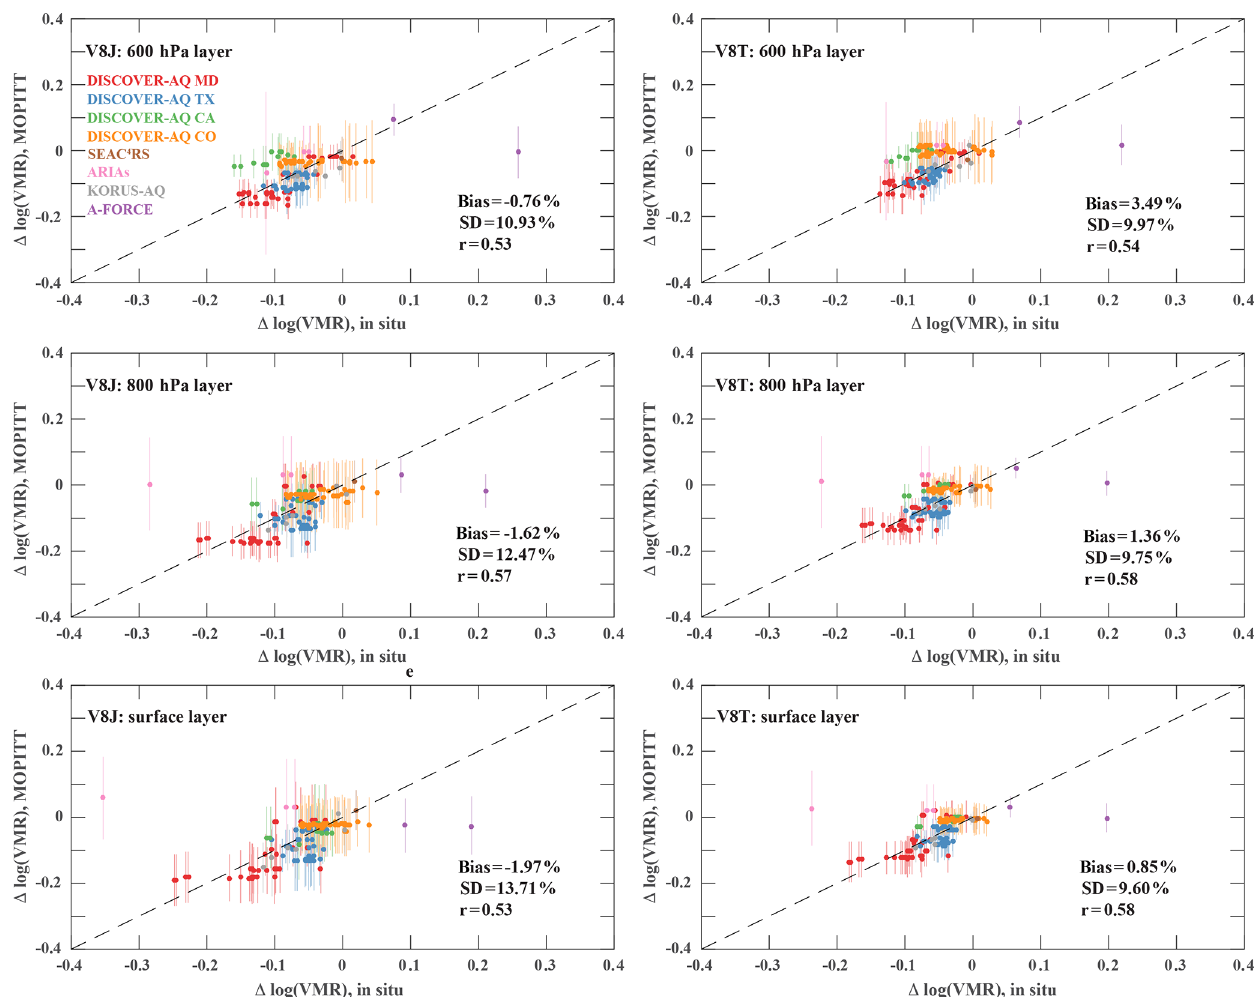
Figure 5. MOPITT V8J and V8T validation results against aircraft profiles over urban regions at the 600hPa layer, the 800hPa layer, and the surface layer in terms of (cid:49) log ( VMR ) . The dashed lines are one-to-one ratio lines. See the caption of Fig.